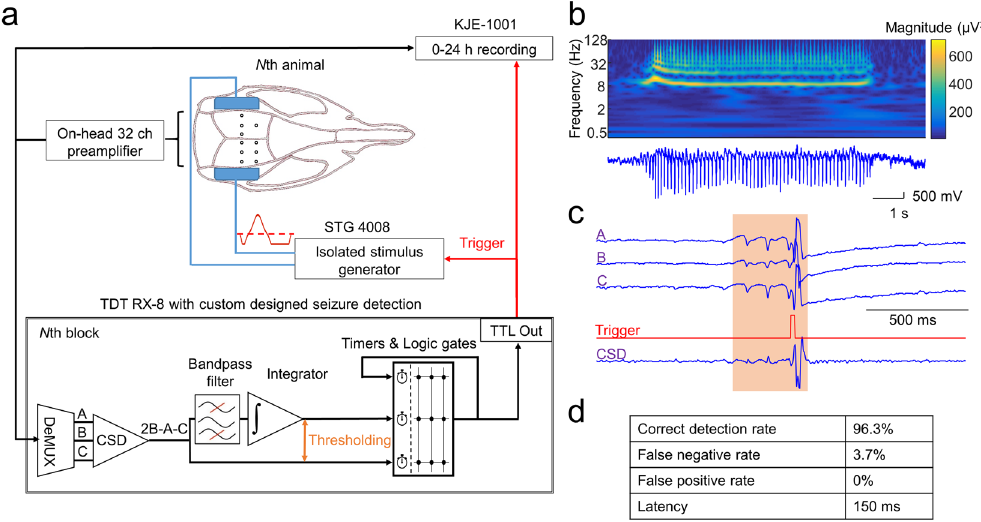
Figure 1. Overview of the closed loop system. ( a ) Cortical LFP from every rat (up to 8 simultaneously, max. 32 channel each) is amplified and multiplexed on-head, and fed to the digital signal processor (TDT RX-8) running a custom designed seizure detection algorithm. The signals were first digitally demultiplexed and CSD of one preselected tripolar electrode was calculated in each rat. Pre-set threshold crossings of the raw CSD and the bandpass filtered, integrated CSD was detected and in case of fulfilling the predetermined seizure criteria (coincidence, regularity) a single isolated, triphasic, charge neutral stimulus pulse was delivered. All the LFP signals and the on-line seizure triggers were continuously recorded for every rat. ( b ) Representative LFP trace and its corresponding wavelet spectrum of a spontaneous SW-discharges. ( c ) Representative LFP traces of a preselected tripolar electrode and the corresponding CSD during a spontaneously emerging interrupted spike- and-wave seizure. ( d ) Seizure detection performance of the closed loop system. Note the very low false negative and virtually absent false positive detections. Latency is determined solely by the seizure detection criteria, as the A/D conversion and the real-time DSP algorithm introduced only a few ms response